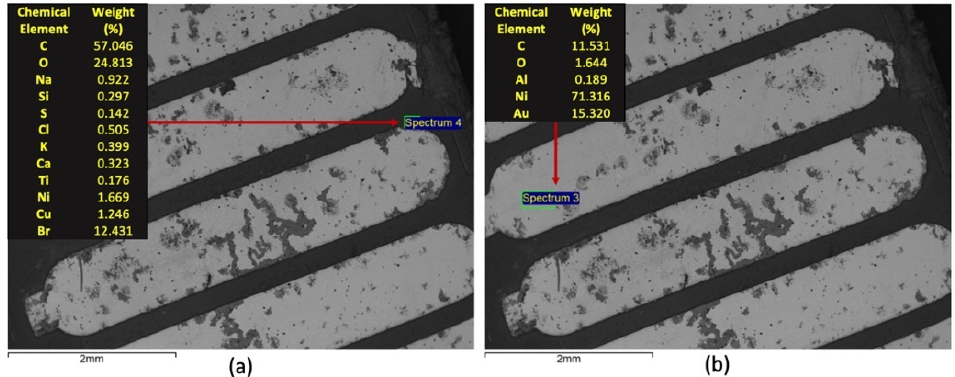
Figure 7. SEM/EDS characterization of Type 3 WEEE sample: ( a ) microanalysis of the dark area; ( b ) microanalysis of the bright area.